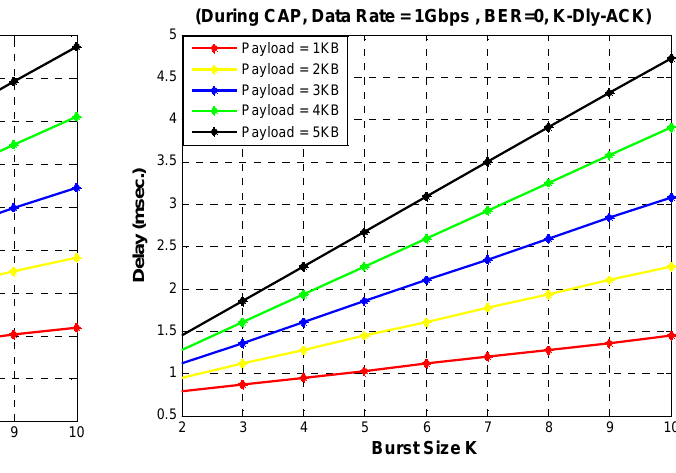
Figure 19. Access delay versus burst